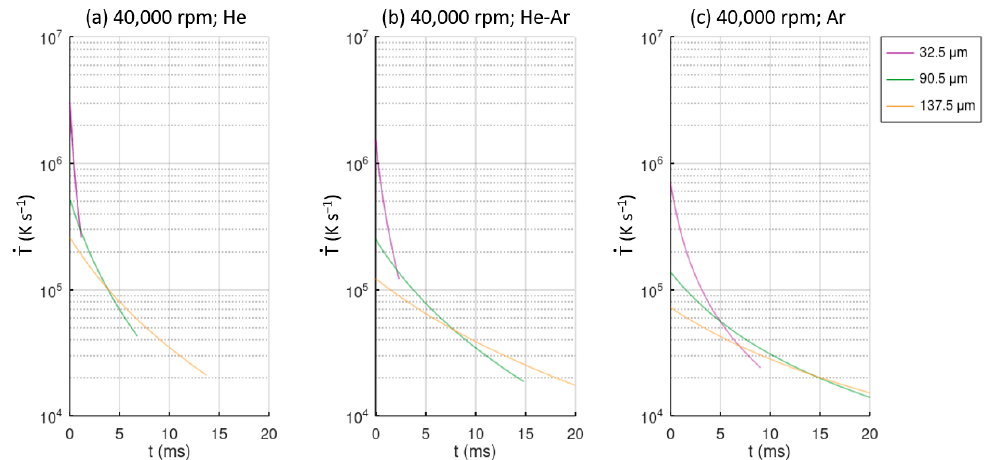
Figure 8. Cooling rate value over time for different particle sizes and different atomization conditions: ( a ) He atmosphere; ( b ) He-Ar atmosphere; ( c ) Ar atmosphere. All cases correspond to a disk velocity of 40,000 rpm.